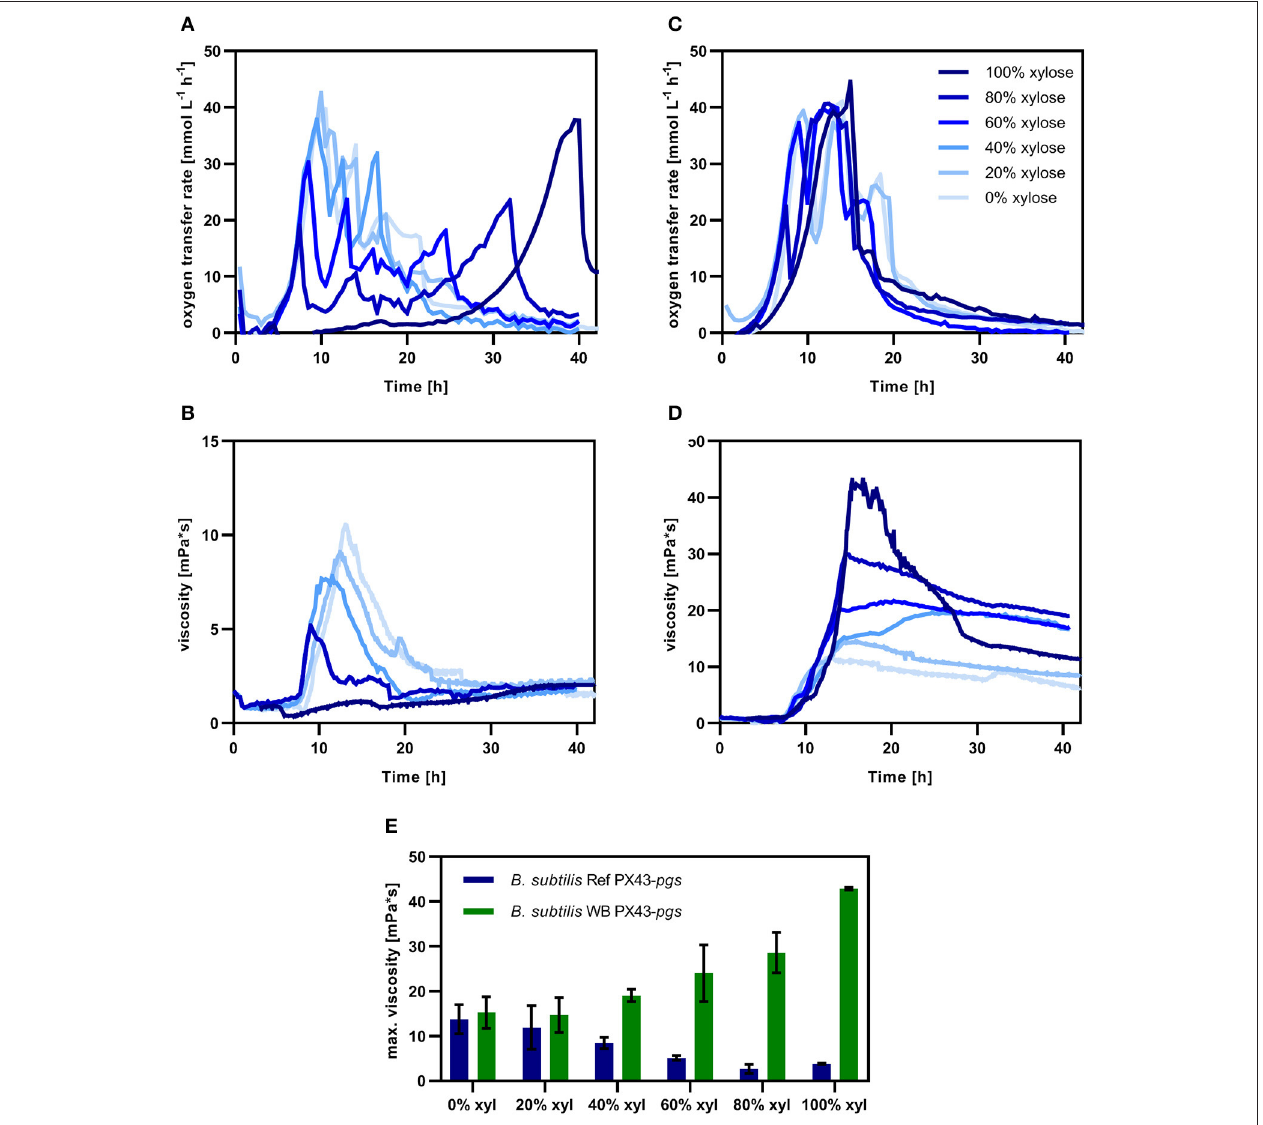
FIGURE 12 | Growth and γ -PGA production of engineered B. subtilis Ref PX43- pgs (reference; A,B ) and B. subtilis WB PX43- pgs (C,D) in glucose/xylose minimal medium in shake flask cultivations. The oxygen transfer rate (OTR) representing the cell growth and metabolic activity of the cultured microorganisms is shown in (A) for the reference strain and in (C) for the Weimberg mutant. The γ -PGA measured as online viscosity is shown in (B) for B. subtilis Ref PX43- pgs and in (D) for B. subtilis WB PX43- pgs with glucose/xylose ratios varying from 0% xyl (100% glucose, 0% xylose) to 100% xyl (0% glucose, 100% xylose). The total substrate concentration was kept constant at 20g L − 1 corresponding to 0.67 C-mol L − 1 . The cultivations were carried out in triplicates for 20, 40, 60, and 80% xylose and in duplicates for 0 and 100% xylose. The obtained maximal viscosity for the reference (blue) and Weimberg mutant (green) is given in (E)